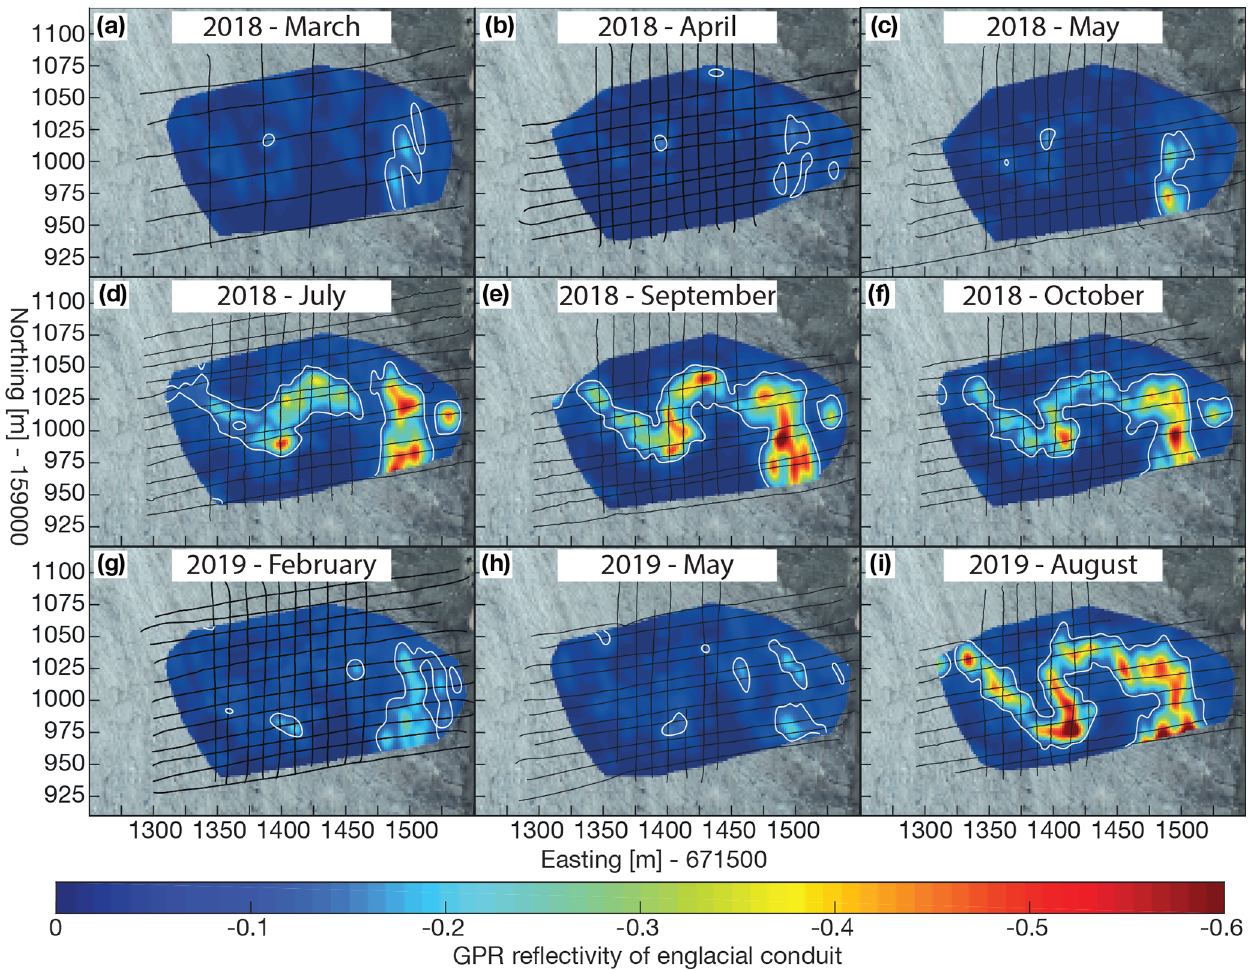
Figure 5. Seasonal GPR reflectivity from the top of the englacial channel reflection. The black grid lines represent the GPR acquisition profiles acquired for each month. The white contour represents the reflectivity at − 0 . 1, providing an approximate outline of the englacial